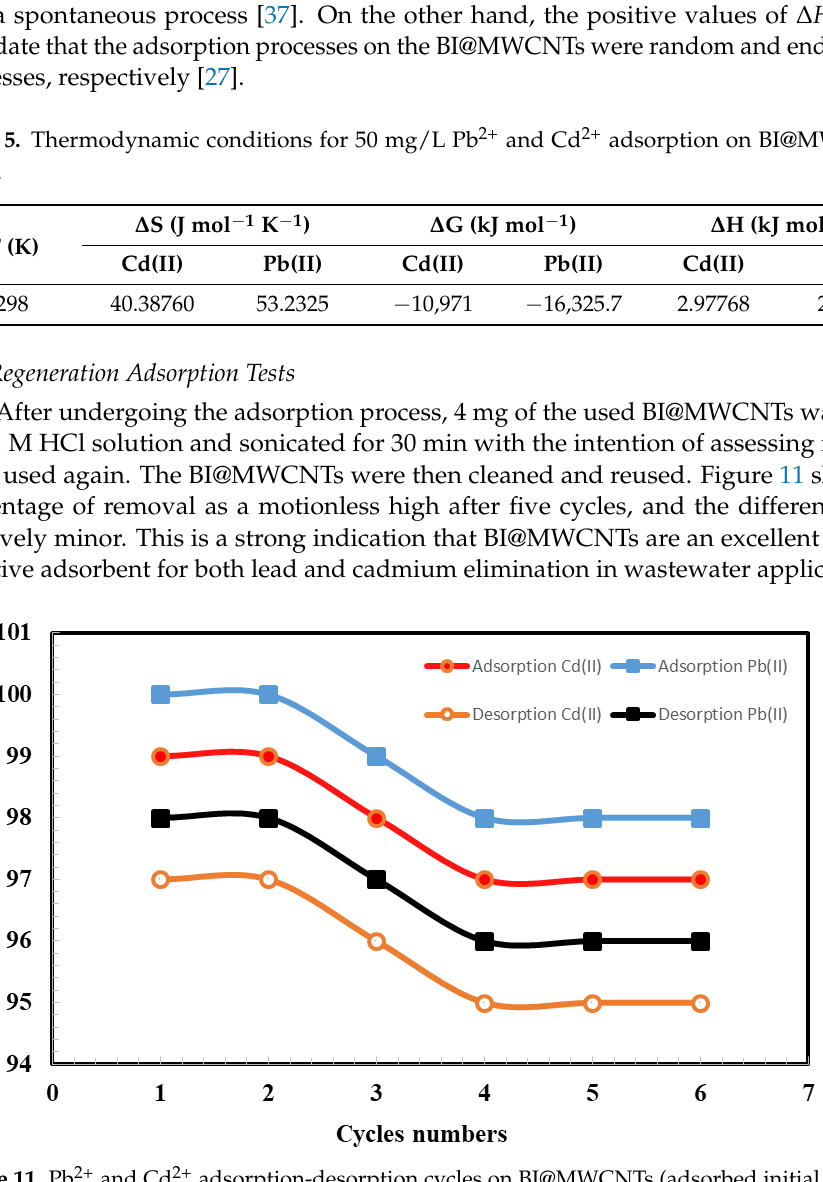
Figure 11. Pb 2+ and Cd 2+ adsorption-desorption cycles on BI@MWCNTs (adsorbed initial concentra- tion, 50 mg/L; adsorbent dose, 4 mg/L; pH, 5.0; temperature, 25 °C).